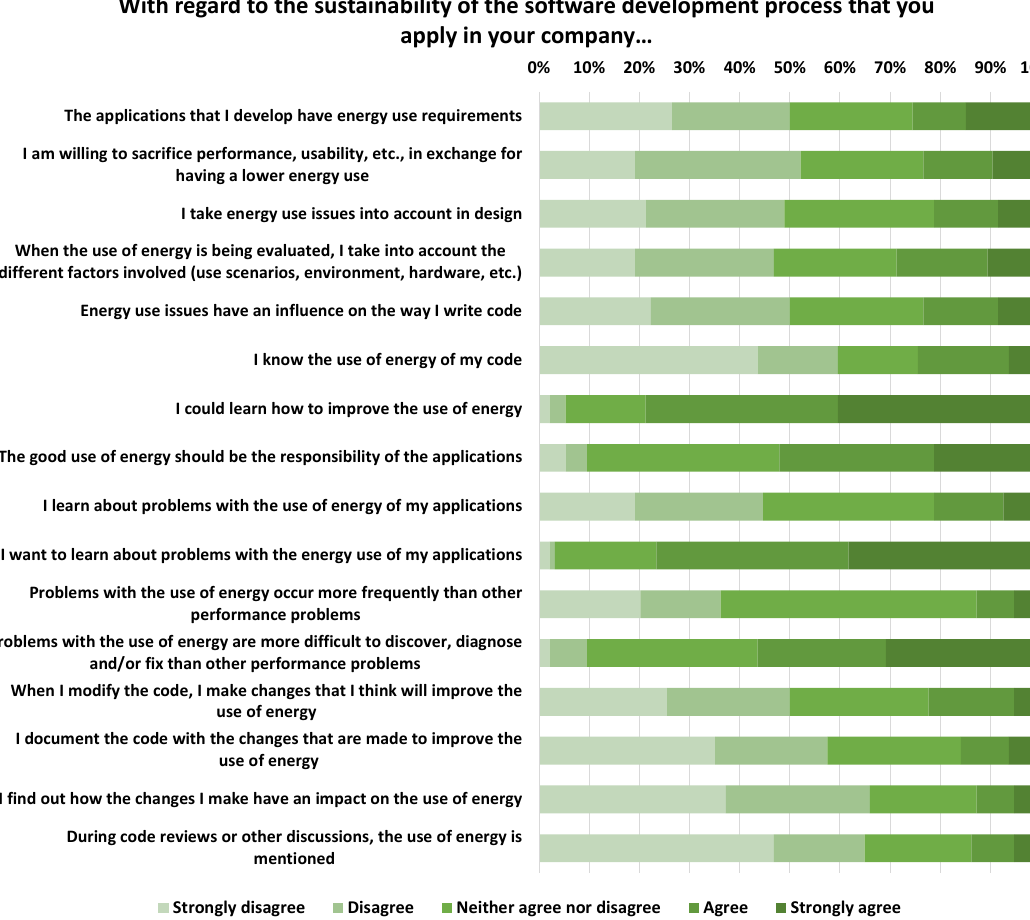
Figure 3. Details on the sustainability of the software development process.